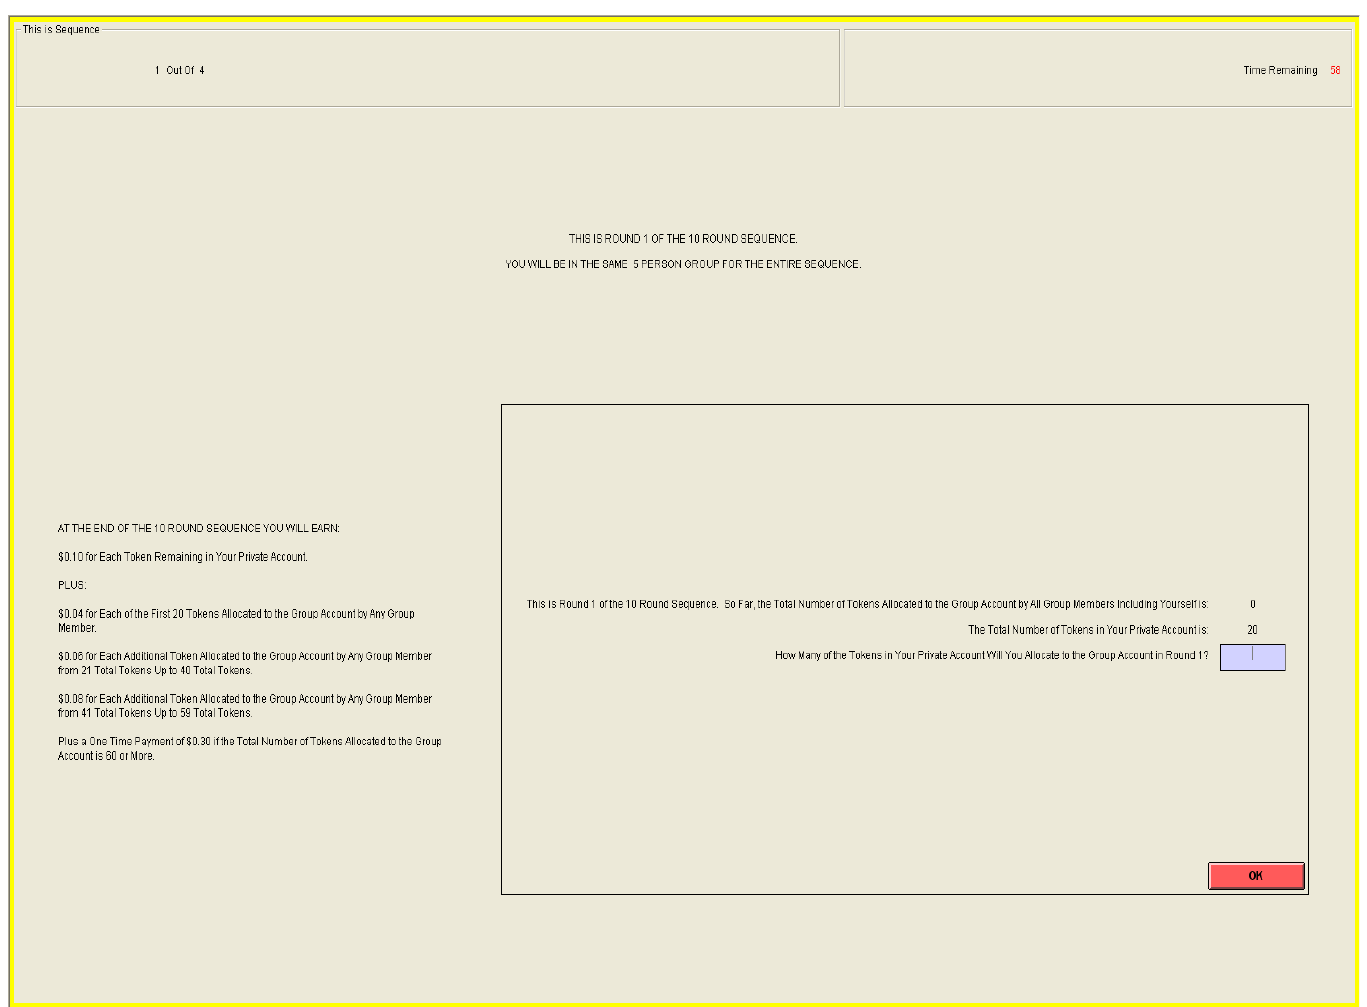
Figure A1. Input Screen.